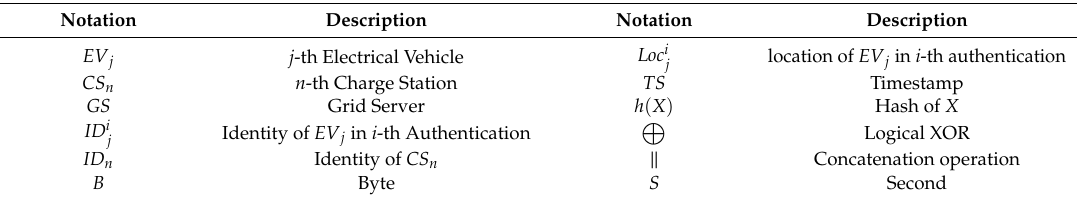
Table 1. Notations and their